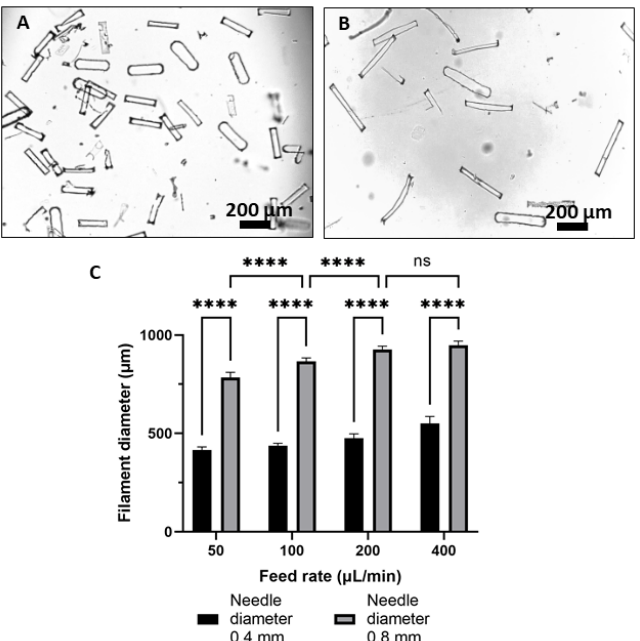
Figure 4. Optical micrographs presenting the morphology of freestanding microrods suspended in water, ( A ) 200 µm length and ( B ) 400 µm length, and ( C ) variation of the diameter of wet spun ADA–GelMA filaments based on using the different needle diameter and feed rate (****, p < 0.0001).